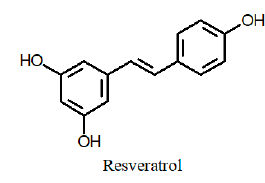
Figure 4. Chemical structures of stilbenes of the genus Cuphea .